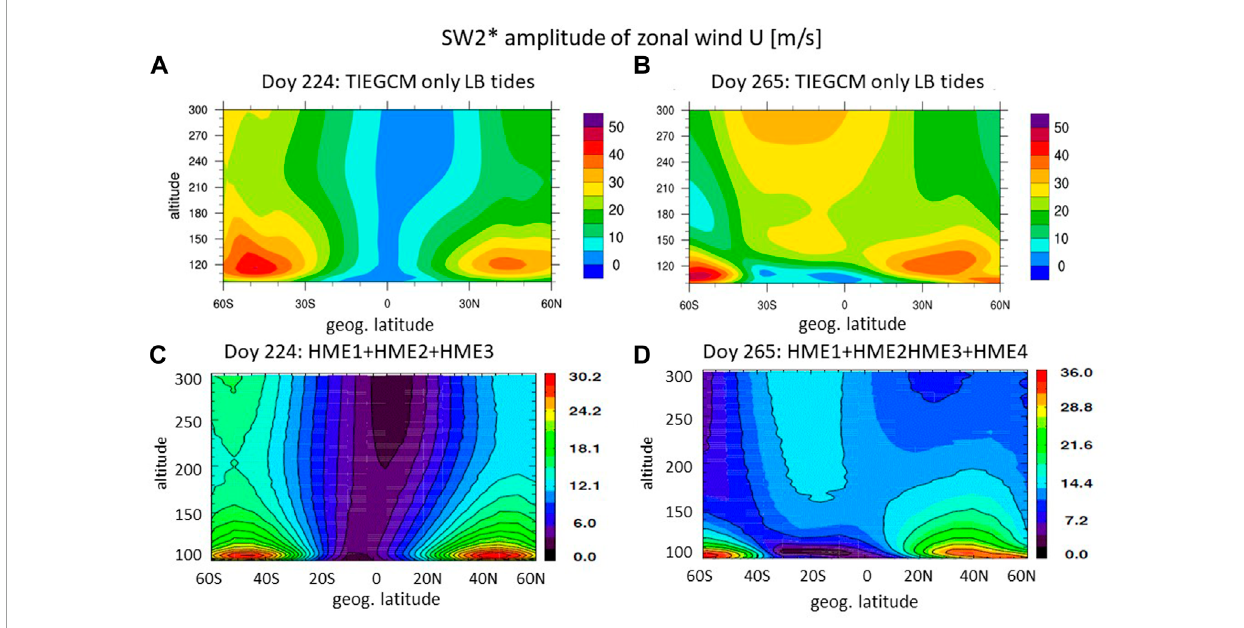
FIGURE 6 Amplitude of semidiurnal migrating tides for zonal wind [m/s] for DOY 224 [left panels (A, C) ] and DOY 265 [right panels (B, D) ] based on TIEGCM only due to LB tides [(top panels (A, B) ] and HME fitting with the least HMEs: 3 modes for DOY 224 (c.) and 4 modes for DOY 265 (D)